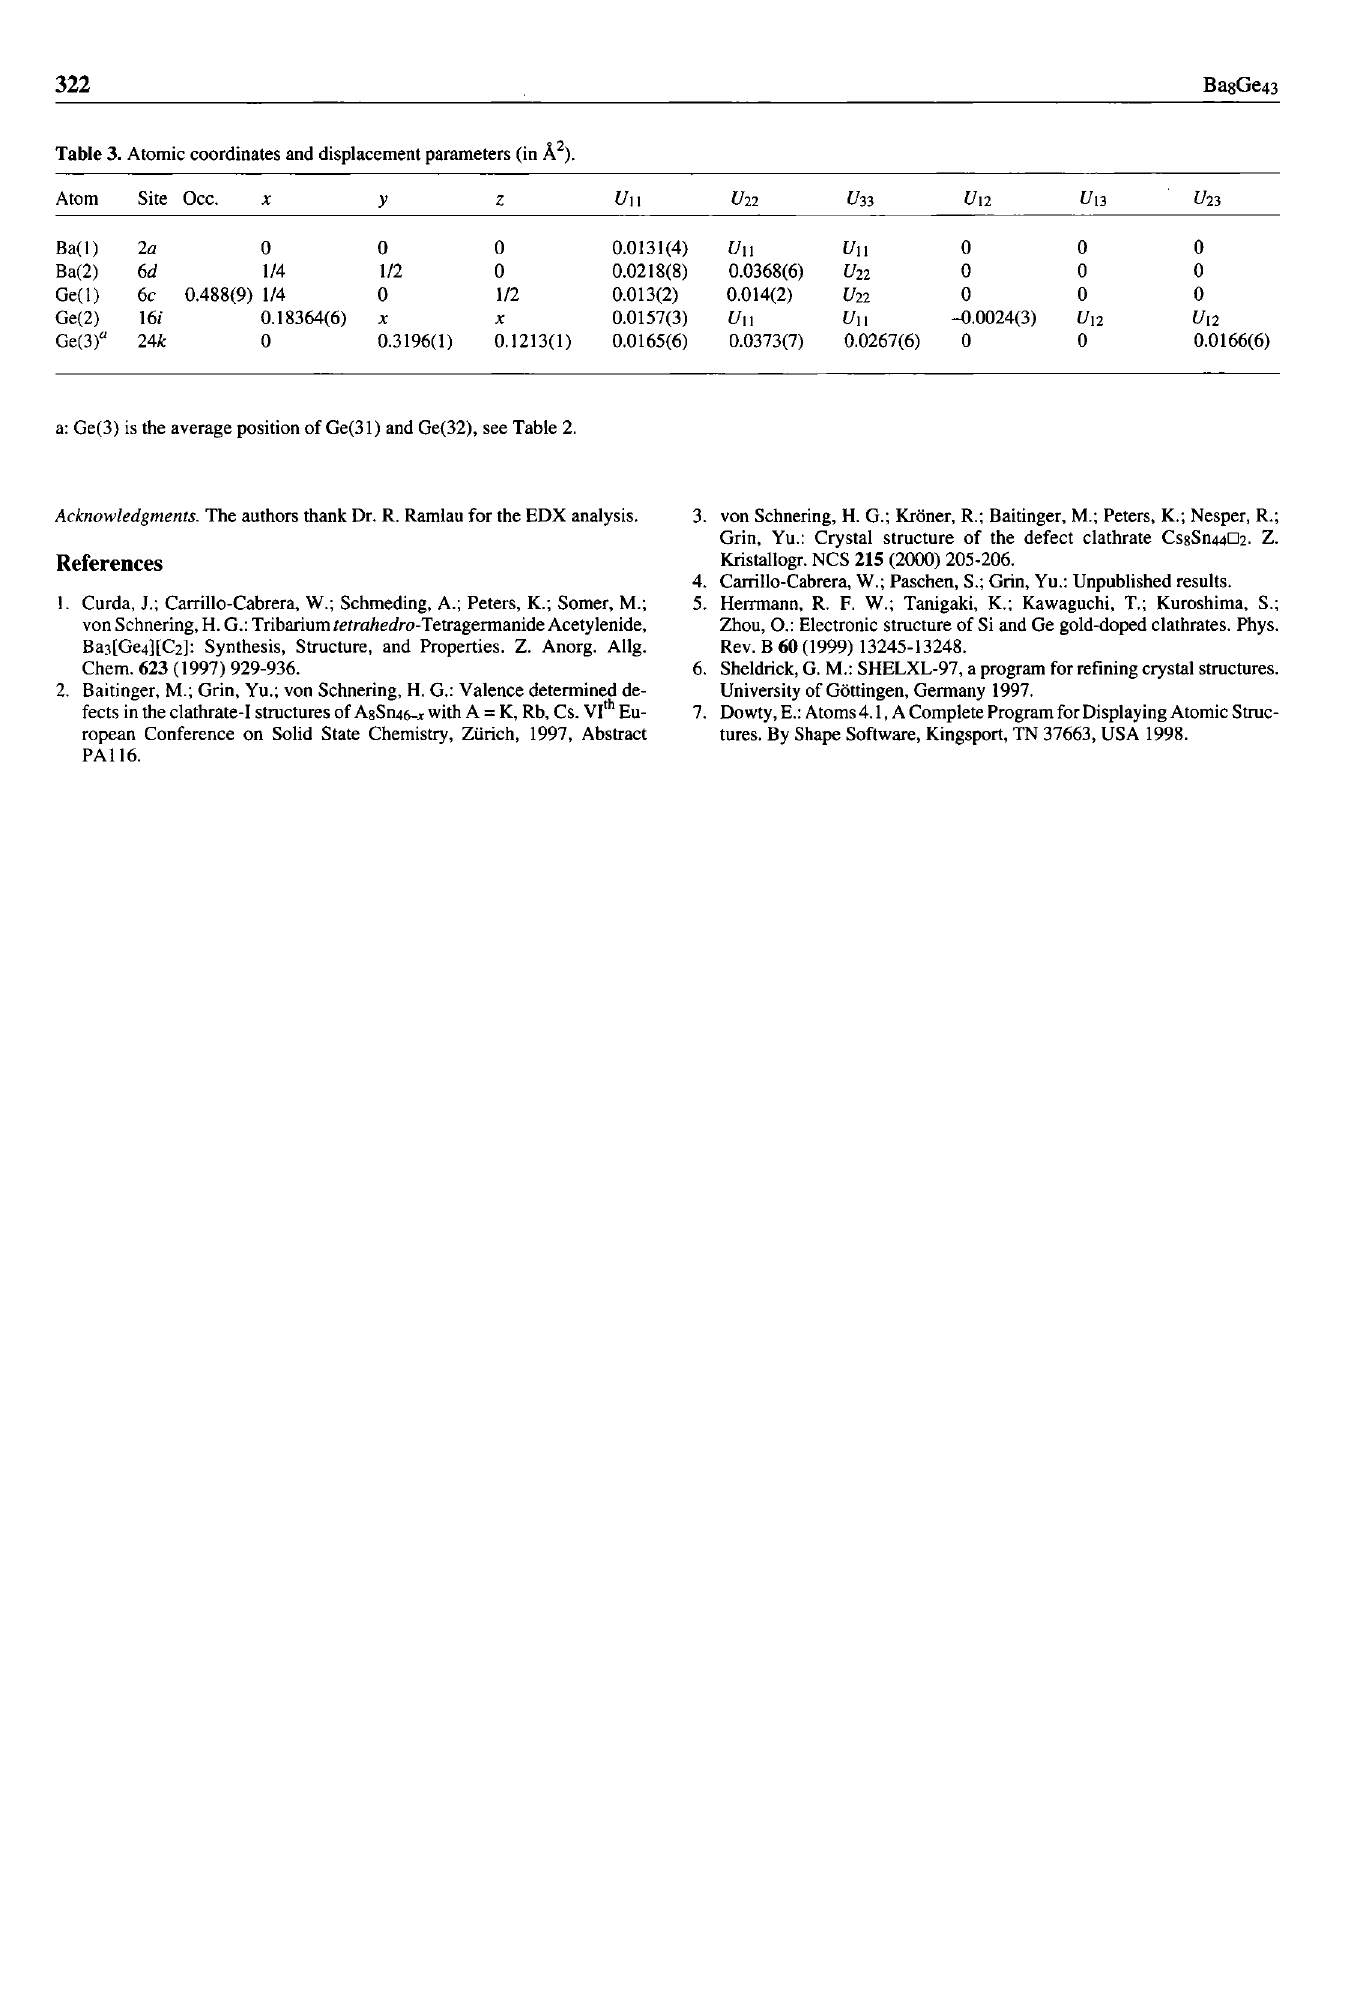
Table 3. Atomic coordinates and displacement parameters (in Ä 2